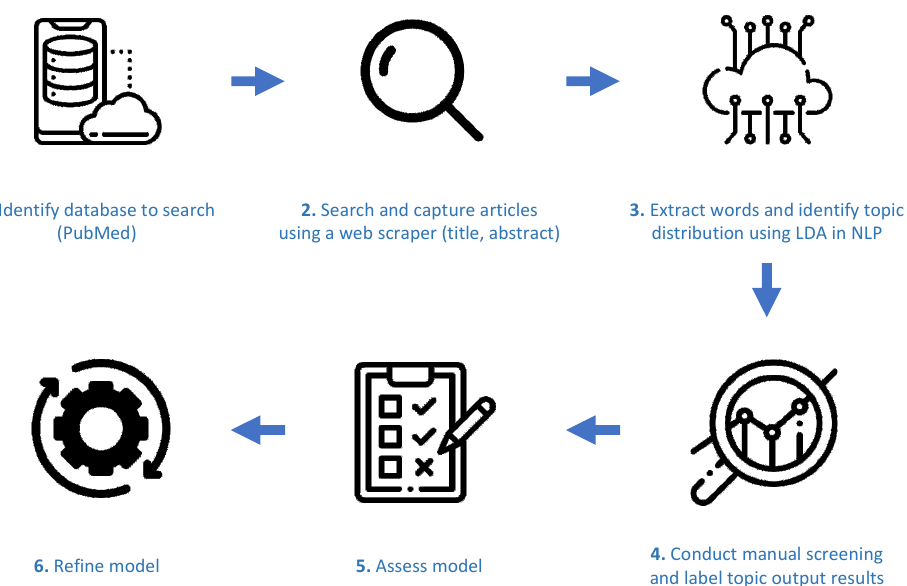
Figure 1. Overview of the text mining approach. Icons from www.flaticon.com/, accessed on 2 June 2021.